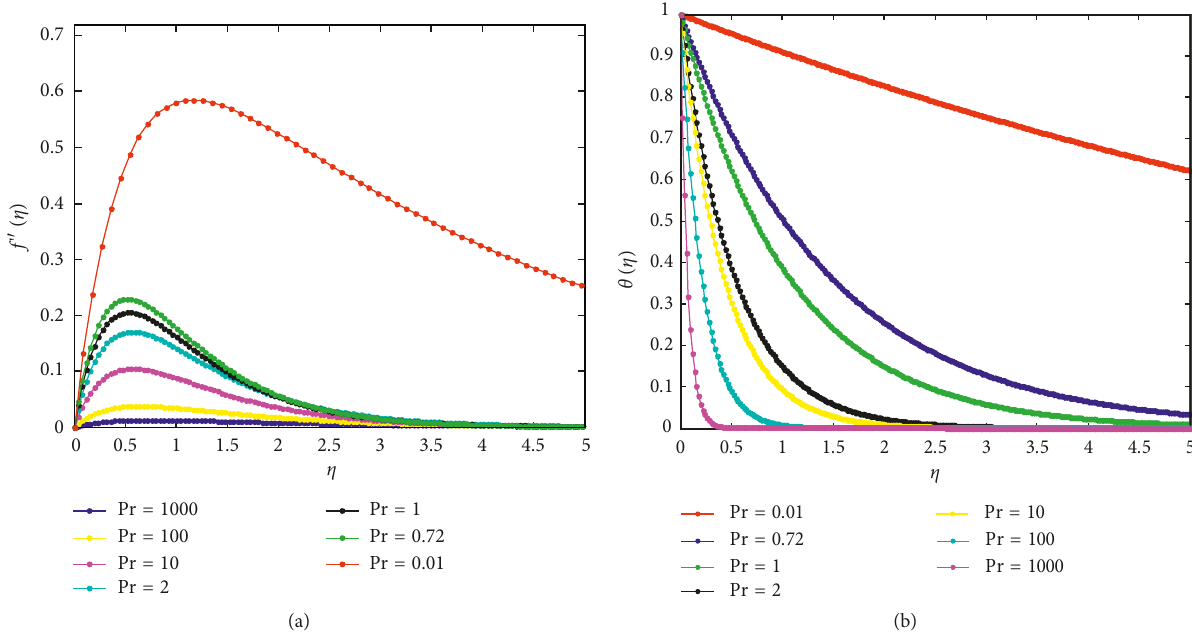
Figure 19: (a) Effects of Prandtl number on the velocity profile for SWCNTnanoparticle. (b) Effects of Prandtl number on the temperature profile for SWCNT